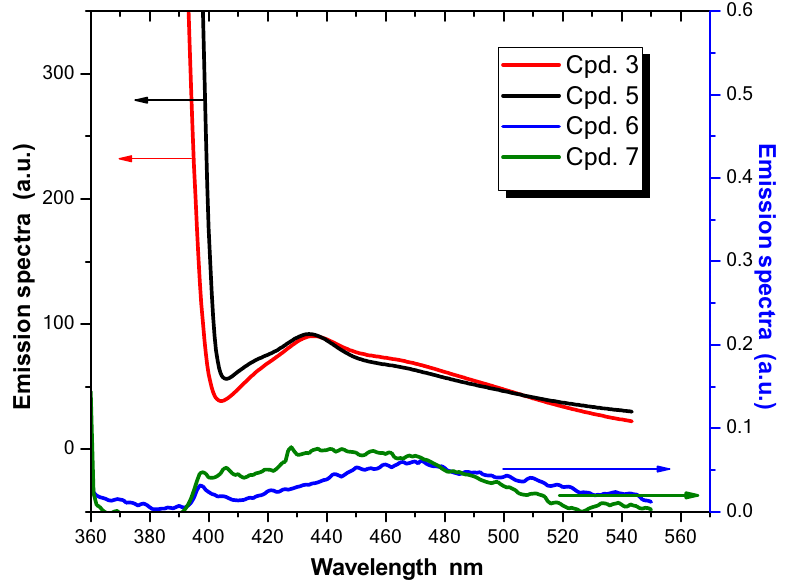
Figure 8. Emission spectra of 2 × 10 –5 M of different triazine chromophores in